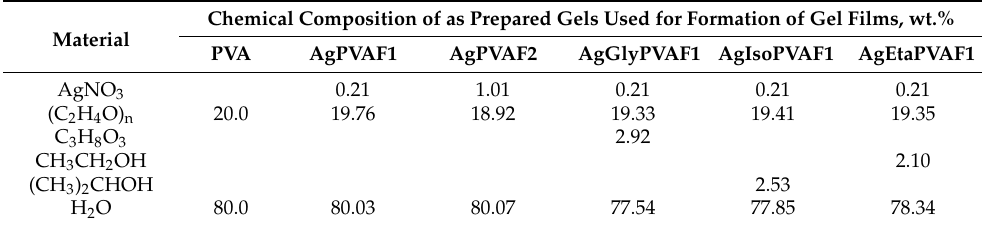
Table 2. Chemical composition of as prepared Ag enriched free-standing PVA